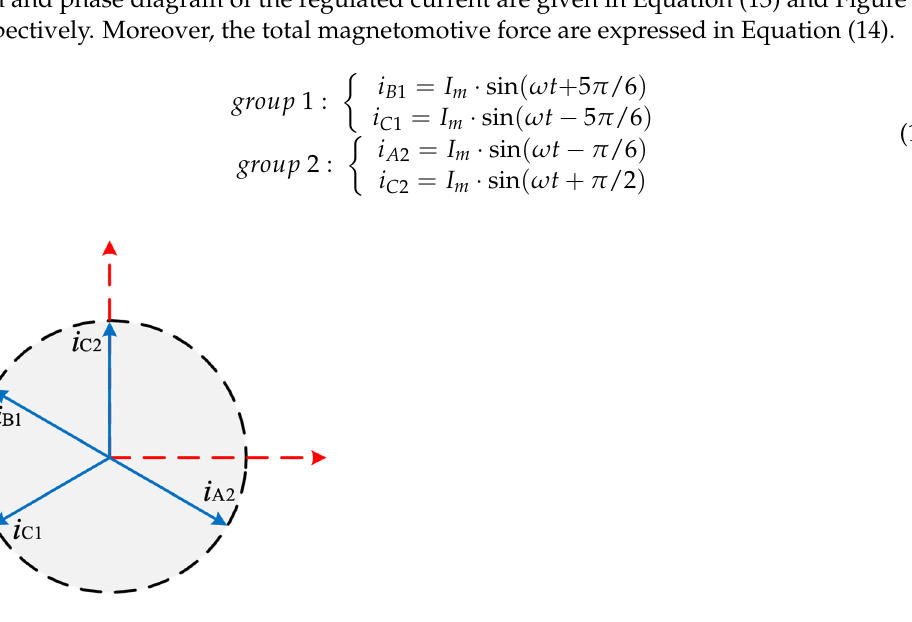
Figure 15. Phase diagram of regulated currents under two-phase open-circuit (Case II: phase A1 and B2 open-circuit) fault-tolerant control.